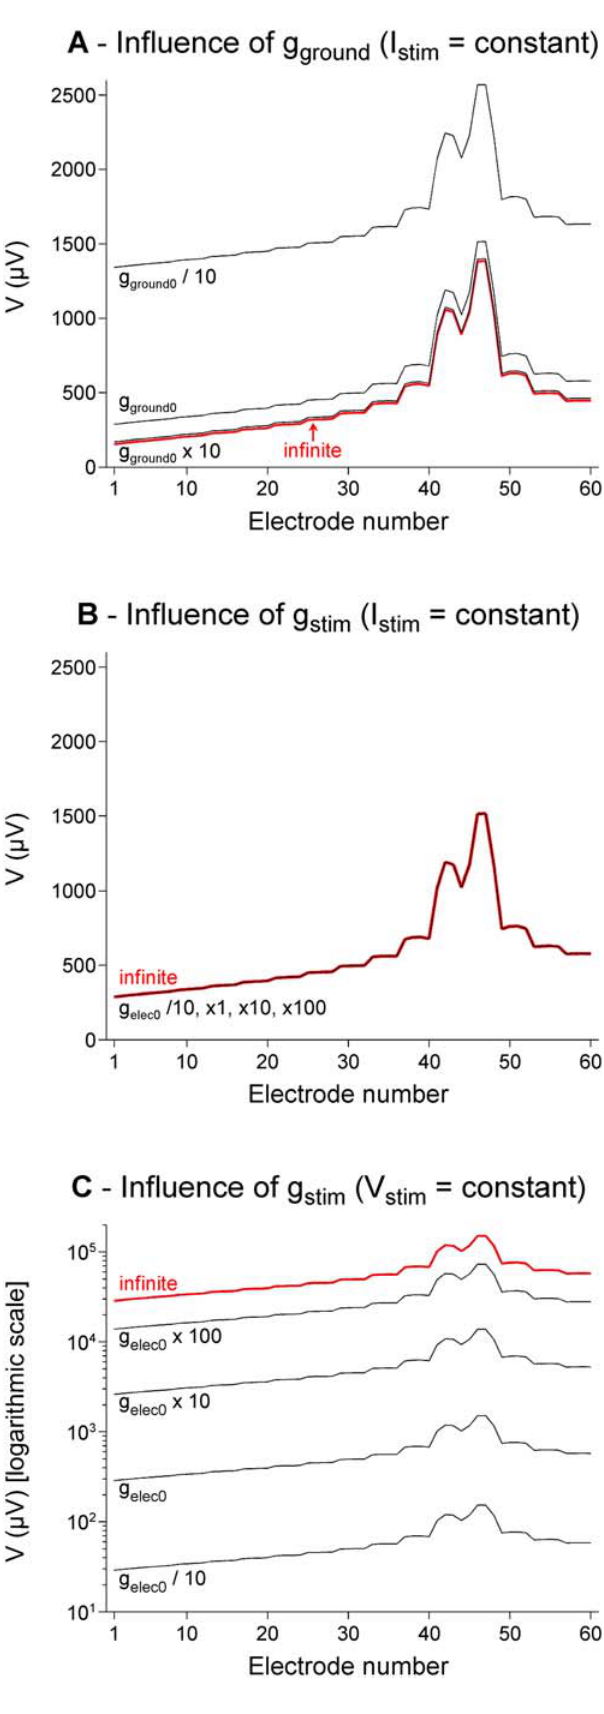
Figure 6. Influence of the surface conductance of the ground and stimulation electrodes on the potential field distribution. Each parameter was varied independently around its initial value fitted in Figure 4 ( g ground =795 S/m 2 , g stim =338 S/m 2 ). For current-controlled stimulations, modifying the ground electrode surface conductance g ground induces a global shift in the offset of the potential distribution. The limit case ( g ground R ‘ ) is computed using a homogeneous Dirichlet BC on the ground surface ( A ). For current-controlled stimulations, the potential field recorded on the 60 electrodes is insensitive to modifications of the stimulation electrode surface conductance g stim ( B ). By contrast, for voltage-controlled stimulations, changing g stim induces a global scaling of the potential field ( C